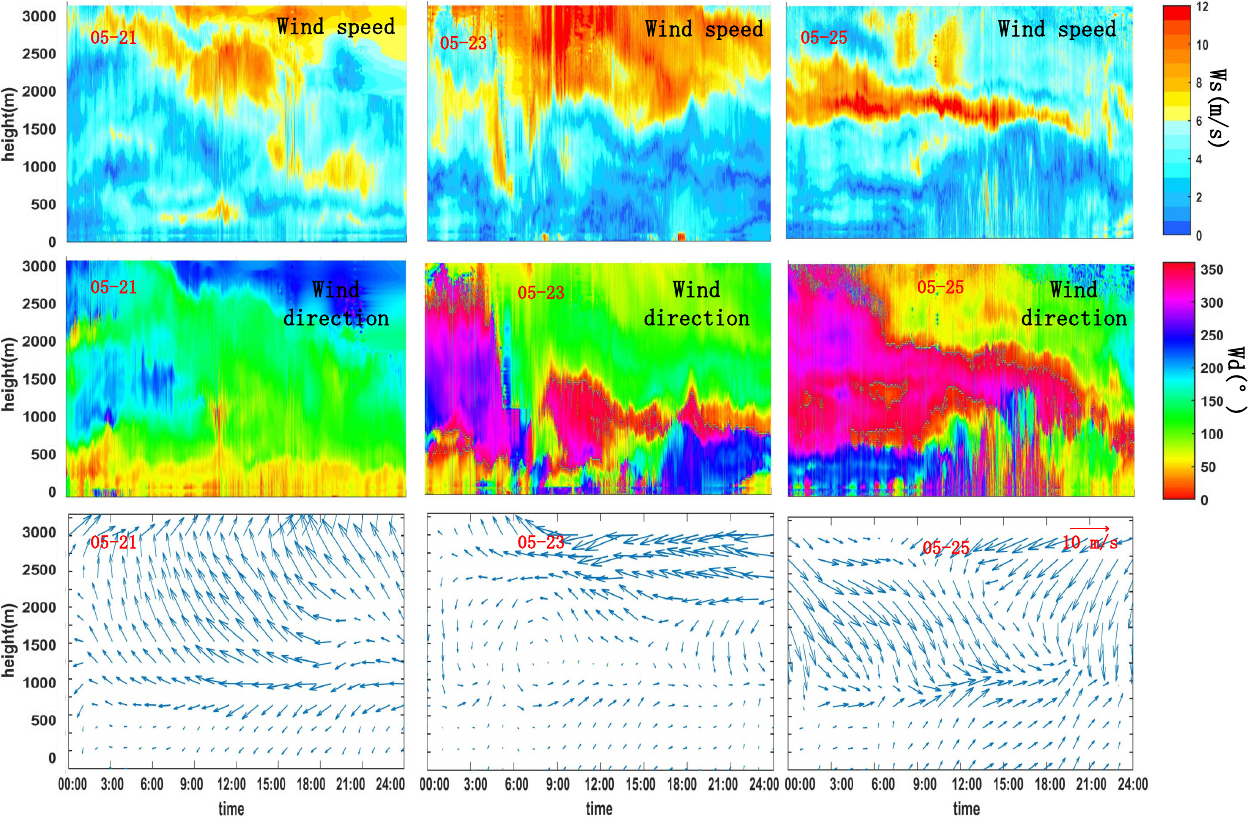
Figure 4. Spatiotemporal distribution of wind speed and wind direction from the PCDL ( top and middle ) and the ERA5 reanalysis data ( bottom ).